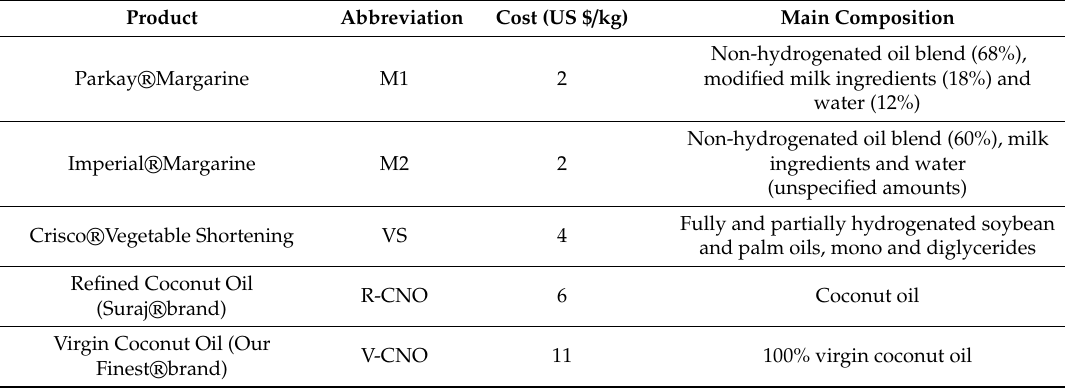
Table 1. Edible fats and oils tested in this study. The abbreviation is the sample name used in the text. The cost is the approximate average retail cost of the brands tested in this study and the composition is from the ingredients specified on the product